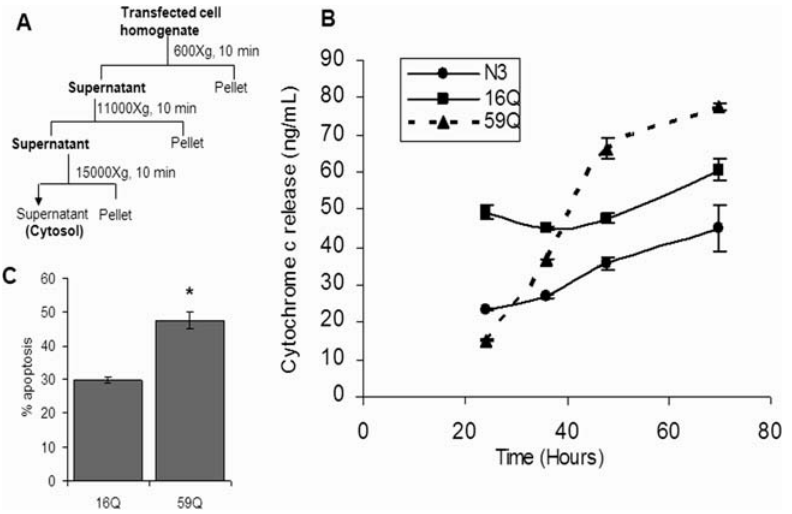
Figure 7. Quantitative analysis of cytochrome c release into the cytosol of transfected Neuro-2a cells. (A) Scheme for isolation of cytosol from cultured cells; (B) Time dependent release of cytochrome c in the cytosol was measured by using a solid phase ELISA assay. Data represents mean 6 SEM (n=2). (C) Apoptosis in 16Q TBPGFP and 59Q TBPGFP transfected cells were analyzed by counting annexinV-PE positive cells in a flow cytometer. Data represents mean 6 SEM of four independent experiments performed. (*, p , 0.01, Student’s t-test).